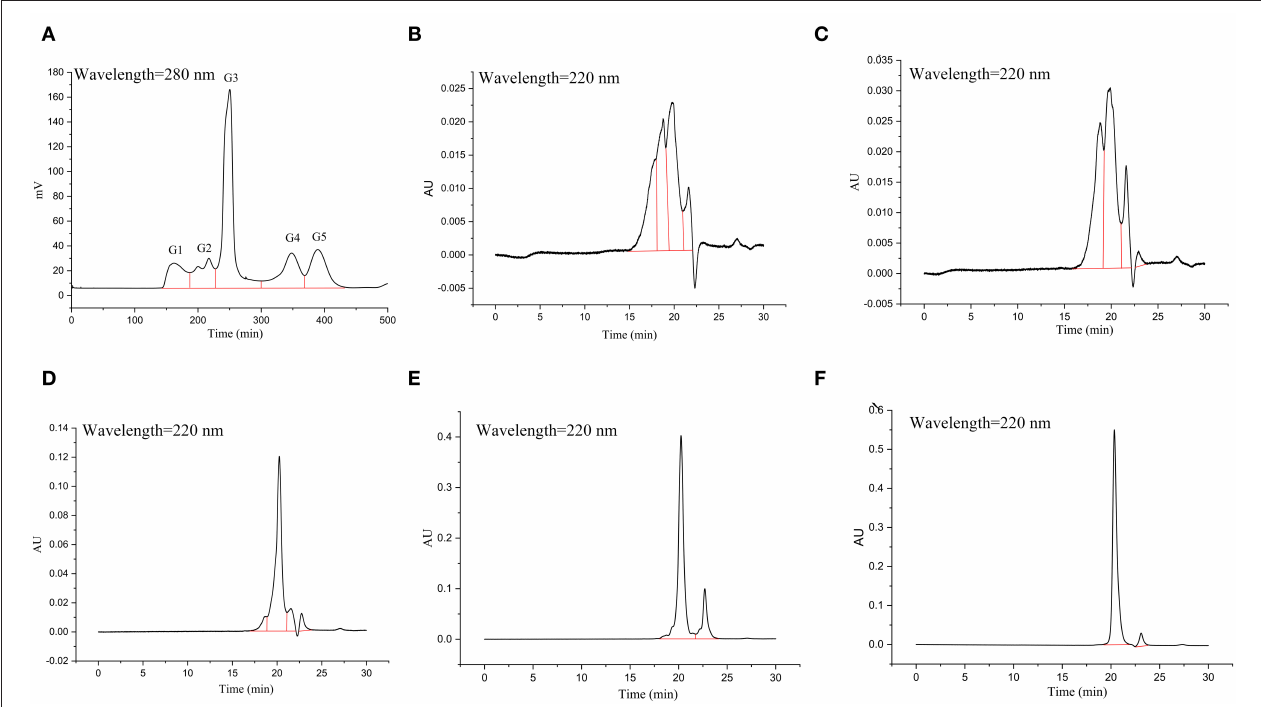
FIGURE 5 | Elution profile and molecular weight of the fraction isolated from UGSPH. (A) The germinated soybean peptide was isolated using gel filtration chromatography on Sephadex G-15. (B) G1, fraction 1; (C) G2, fraction 2; (D) G3, fraction 3; (E) G4, fraction 4; and (F) G5, fraction